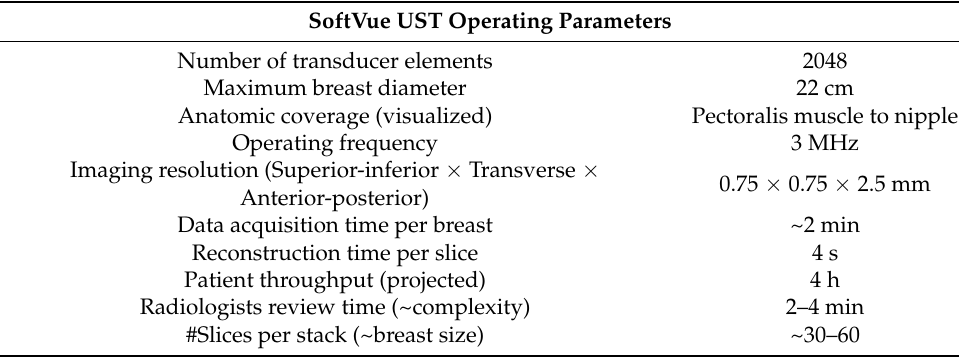
Table 1. Current clinical operating parameters of SoftVue UST